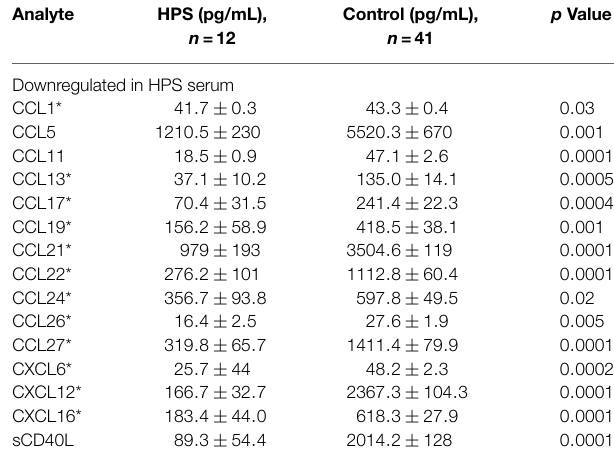
TABLE 3 | Cytokines downregulated in HPS cases compared to healthy controls